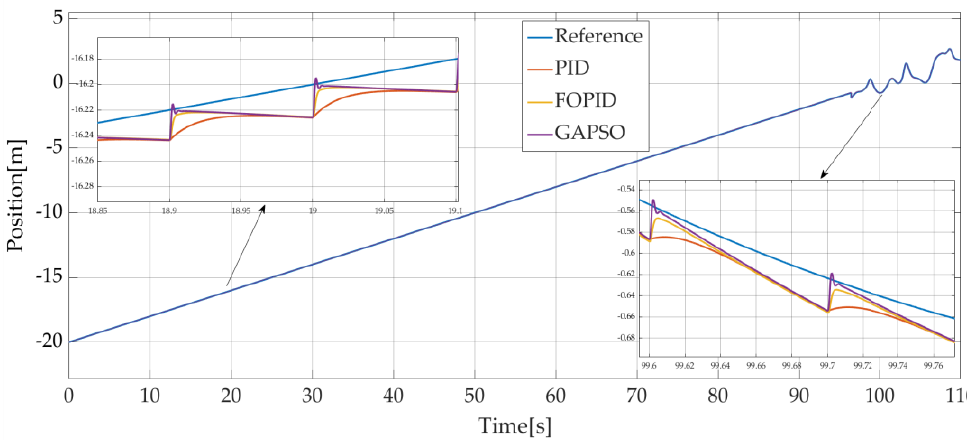
Figure 16. L = 5 m, V = 0.2 m/s Position of the load with compensation.